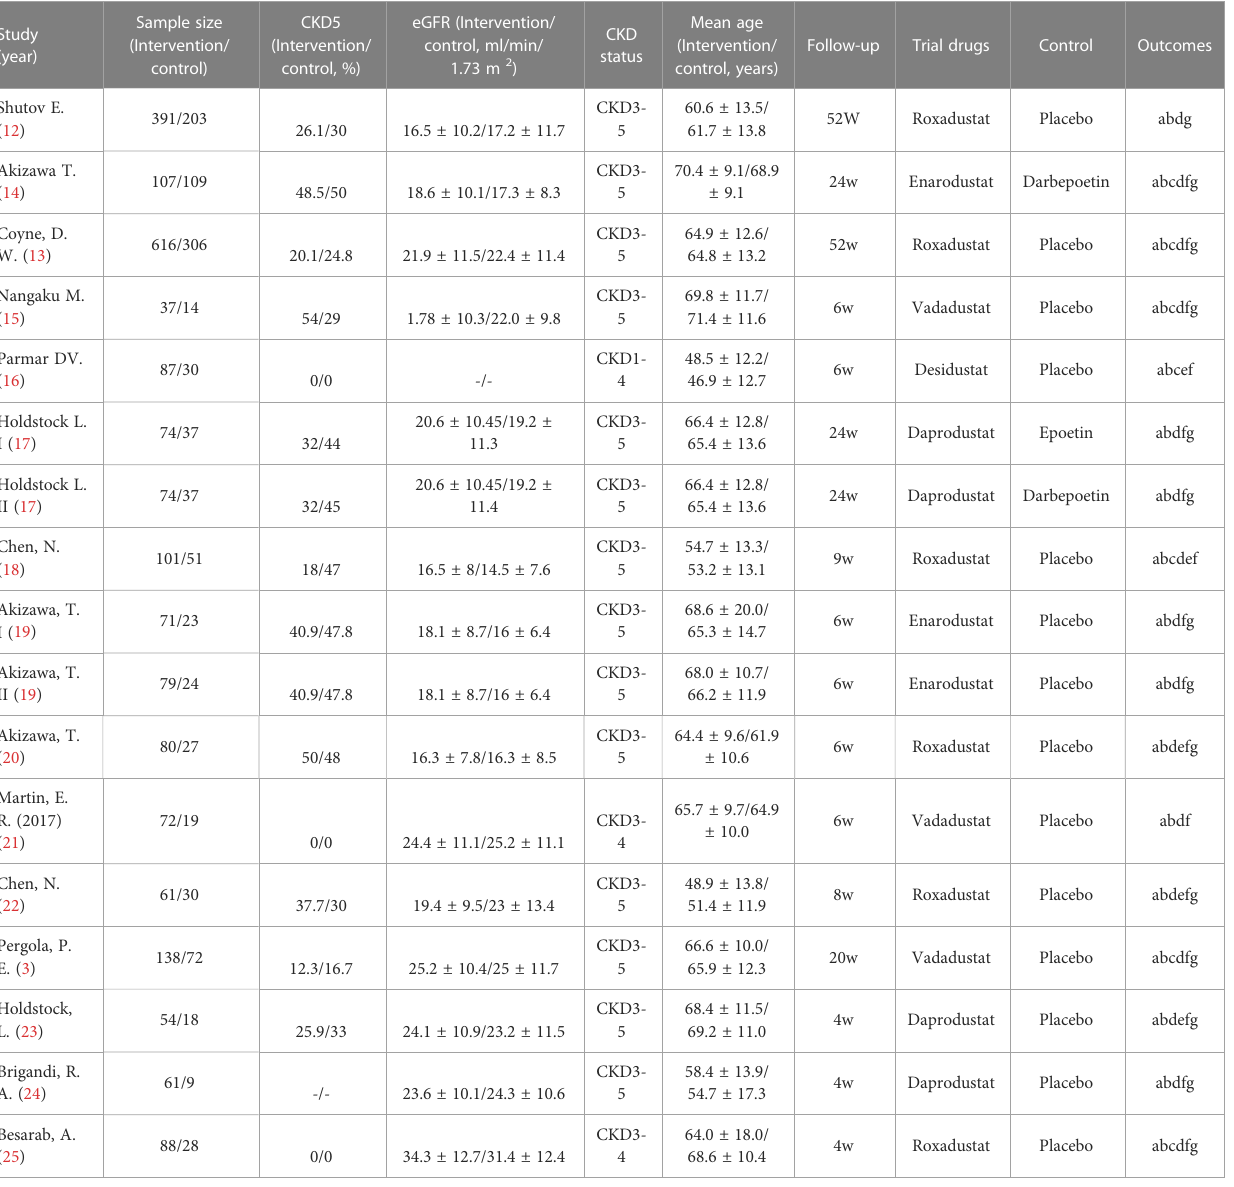
95%CI: 5.71 to 6.96) (Figure 7E). HIF-PHIs signi fi cantly reduced TSAT compared with placebo (MD=-3.27, 95%CI: -4.00 to -2.53) and ESAs (MD = -4.73, 95%CI: -5.52 to -3.94), while ESAs could signi fi cantly raise TSAT than placebo (MD = 1.47, 95%CI: 0.38 to 2.55) (Figure 7F).